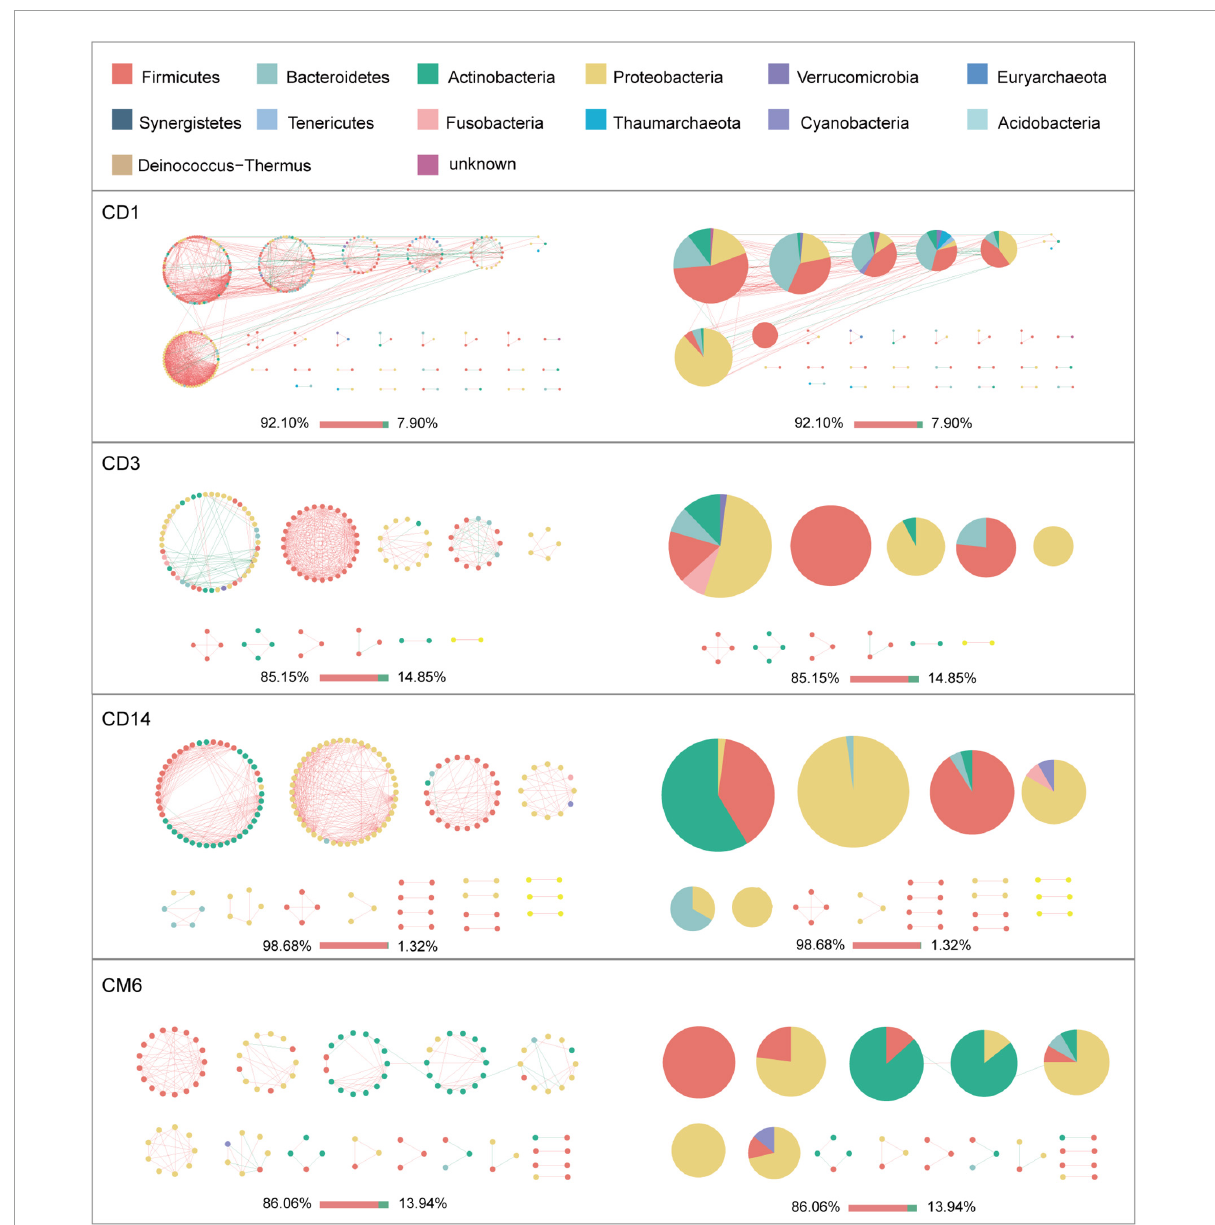
FIGURE5 Modules within gut microbial networks of infants in the control group. The colors of nodes represent different major phyla; pie charts exhibit the phylum level composition of modules with ≥ 5 nodes. Red edges indicate positive correlations between nodes, whereas green edges indicate negative correlations. The bar underneath each networks demonstrate the proportion of positive and negative